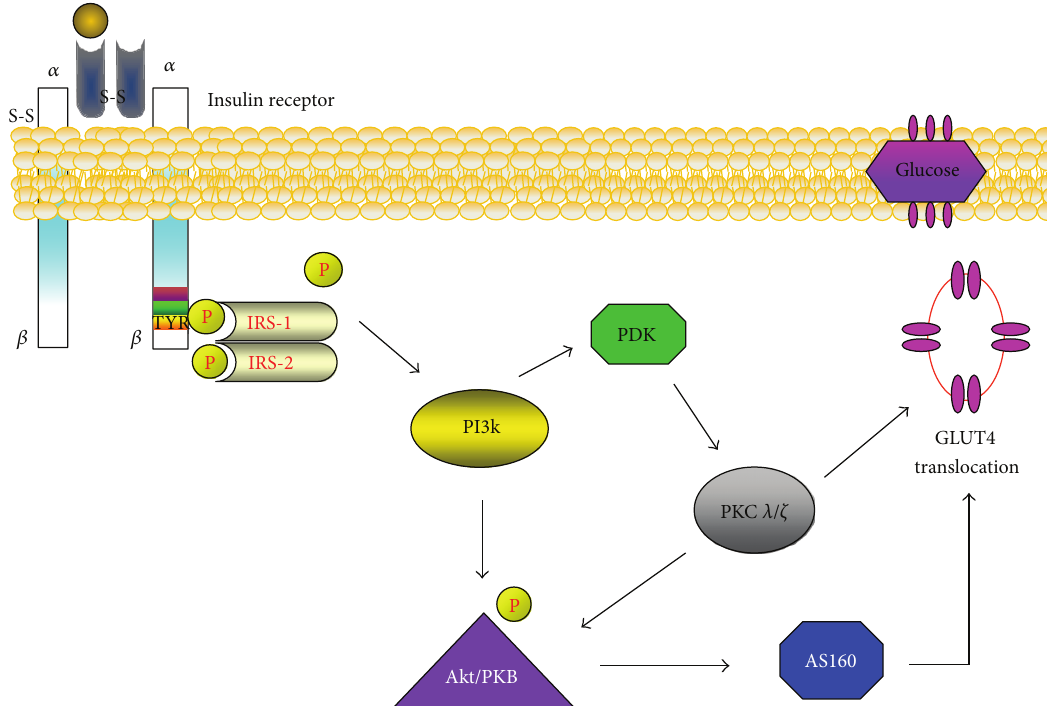
Figure 4: In brief, the insulin binds with its membrane receptor which has intrinsic tyrosine kinase activity, triggers a signaling cascade to downstream substrates resulting in glucose transport. Subsequently, tyrosine phosphorylated IRS (IRS-1/2) recruits signaling molecules incluinding phosphoinositide 3-kinase (PI3k). After a activation of PI3k a complex formation ofphosphatidylinositol-3,4,5-trisphosphate (PI3P) that serves as regulator of phosphoinositide-dependent kinase (PDK) which was later shown to activate others prototypes proteins kinase (e.g., PKC). With this, the protein Akt is activated and propagates the hormonal signal to activate protein AS160 (GTPase activating protein of 160kDa), which in turn sensitizes the glucose transporter in skeletal muscle (GLUT-4) to the translocation process to the lipid membrane to glucose uptake